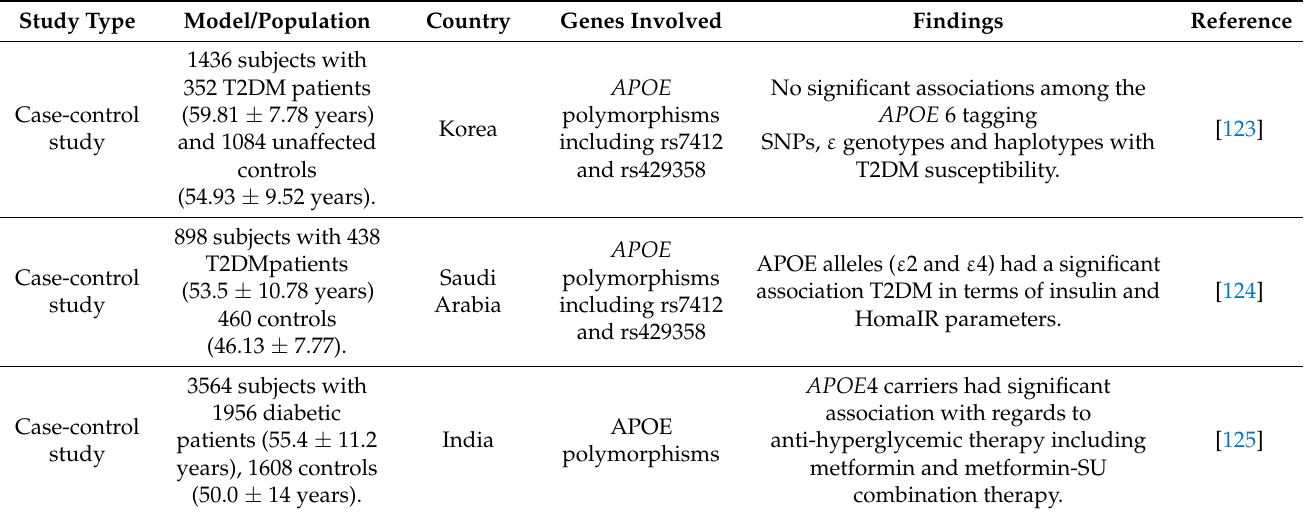
Table 7. The relationship between apolipoprotein and